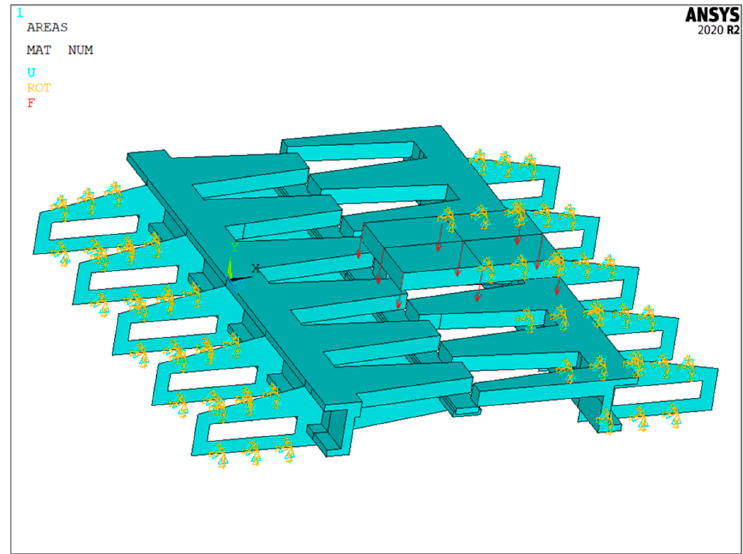
Figure 15. FEM of the expansion joint under fatigue test condition.